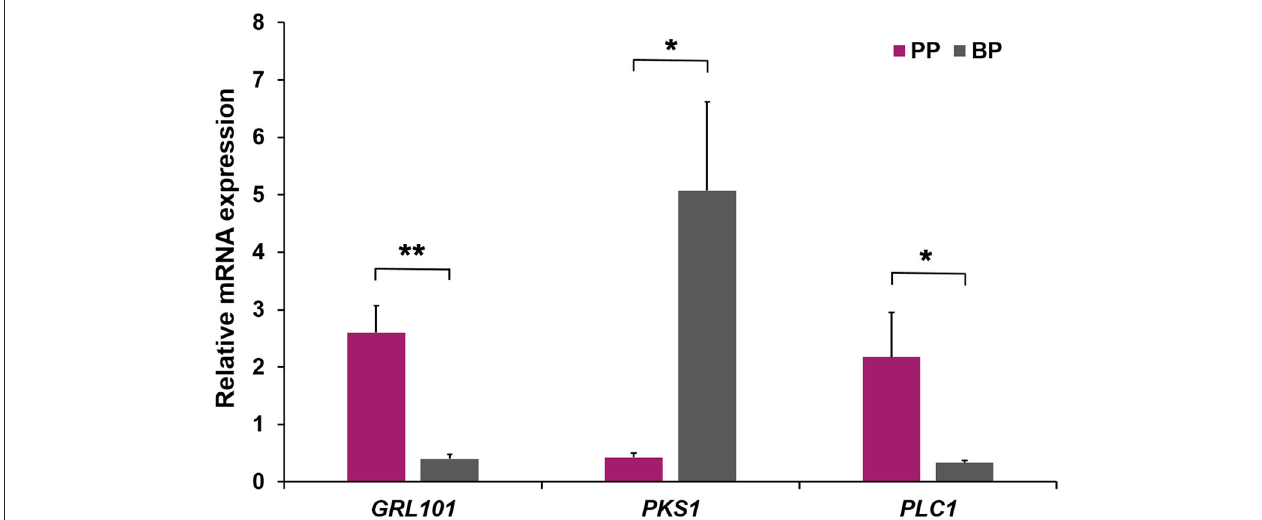
FIGURE 6 | The relative expression levels of GRL101 , PKS1, and PLC1 in the mantle of PP and BP bay scallops. Three replicates were performed for each adult mantle, and three technical replicates were conducted for each PCR. The comparison of the expression levels of GRL101 , PKS1, and PLC1 in the mantle of PP and BP bay scallops was performed using an independent sample t -test. * and ** indicate statistically significant differences ( p < 0.05 and p < 0.01,